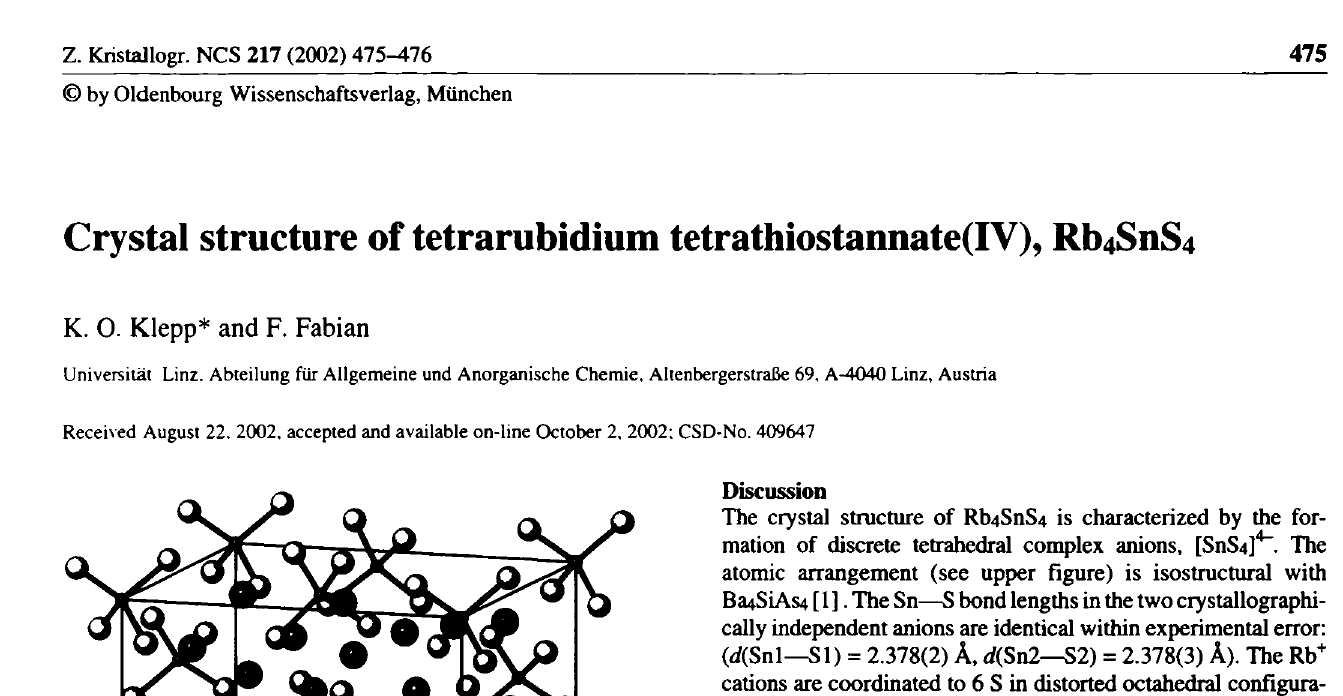
Table 1. Data collection and handling.